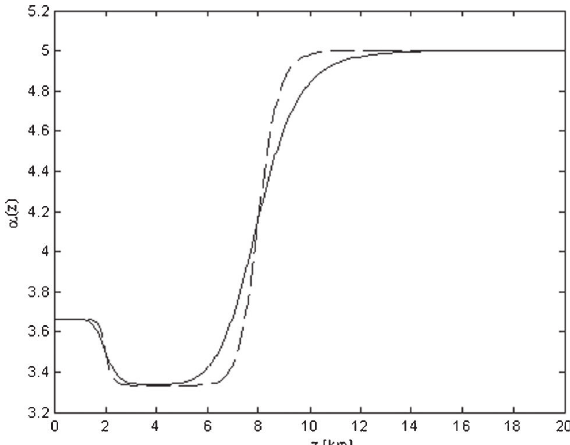
Figure 8. Three-layer model of non-Kolmogorov turbulence spectrum exponent α versus height z [m] above the ground. Solid curve: b 1 = 8, b 2 = 10; Dashed curve: b 1 = 15, b 2 = 20. Reprinted with permission from Reference